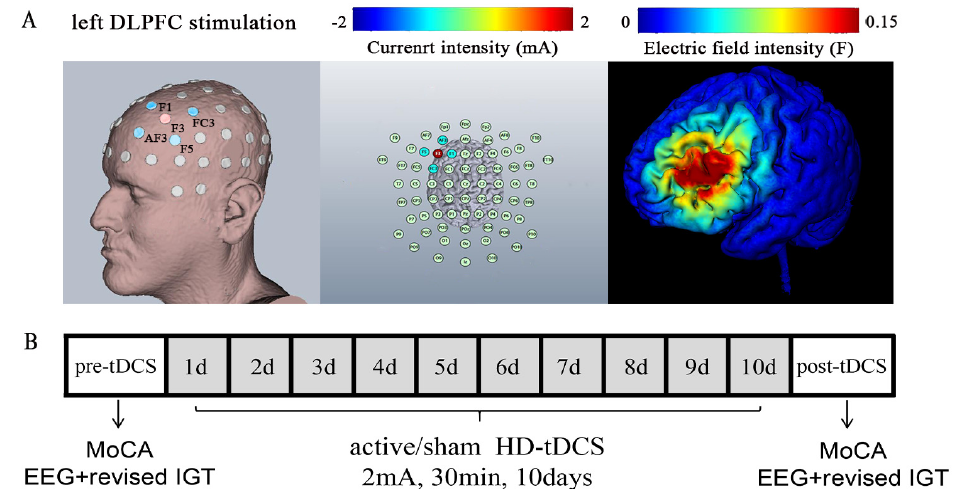
Figure 1. The experimental protocol and high-definition neuromodulation guided by model. ( A ) shows the study was completed within 12 days. Ten consecutive days for HD-tDCS sessions, two days for EEG recording and cognitive assessment which occur before HD-tDCS and after HD-tDCS. ( B ) shows the three-dimensional reconstructions of cortical of the electrical field models and the left DLPFC HD-tDCS protocols. The left DLPFC protocol included (in mA): F3 (2.0), AF3( − 0.5), F1 ( − 0.5), F5 ( − 0.5), FC3 ( −